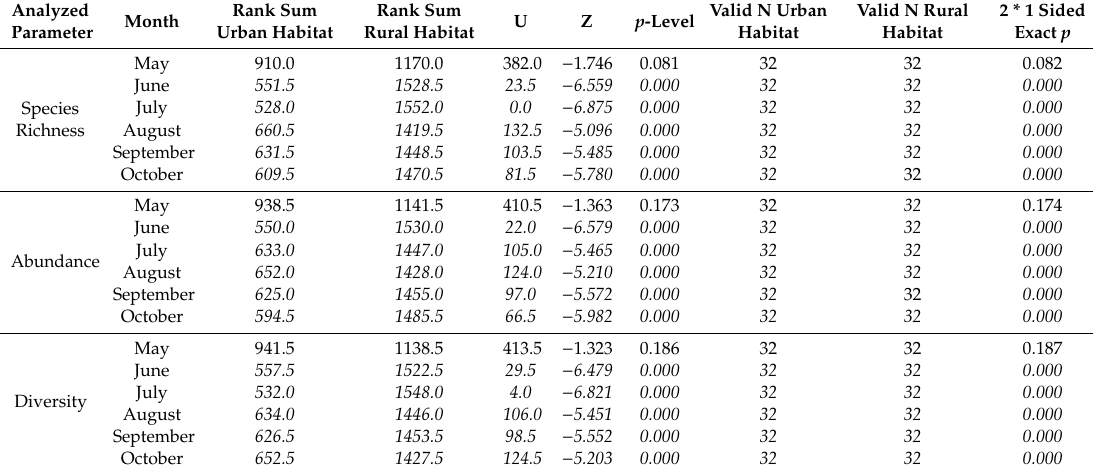
Table 3. E ff ect of habitat type and individual months of the vegetative season on species richness, abundance, and diversity, assessed by the Mann–Whitney U test (U and Z are measures of the significance of the di ff erence between the samples, based on the sum of ranks and distance from the mean; N is the number of the samples (trees)